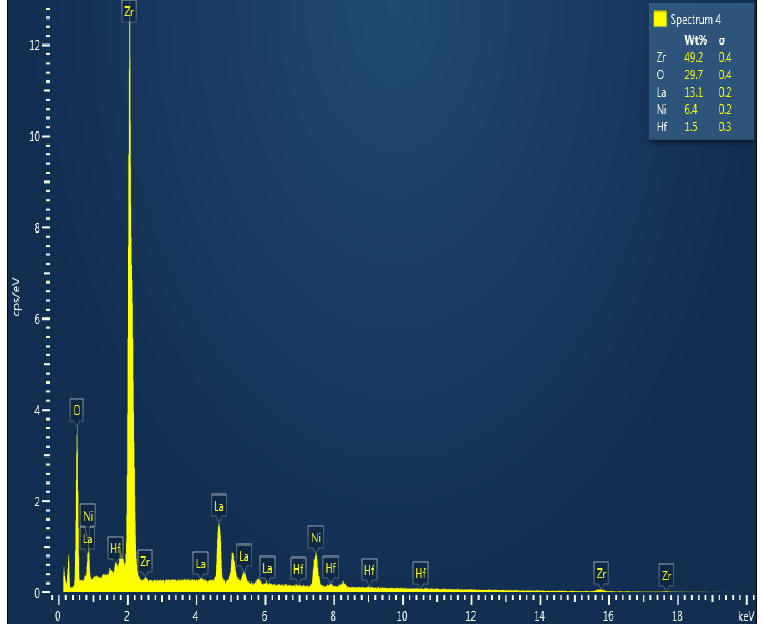
Figure 8. The Energy Dispersive X-ray (EDX) analysis of 5Ni-10 La 2 O 3 -ZrO 2 .